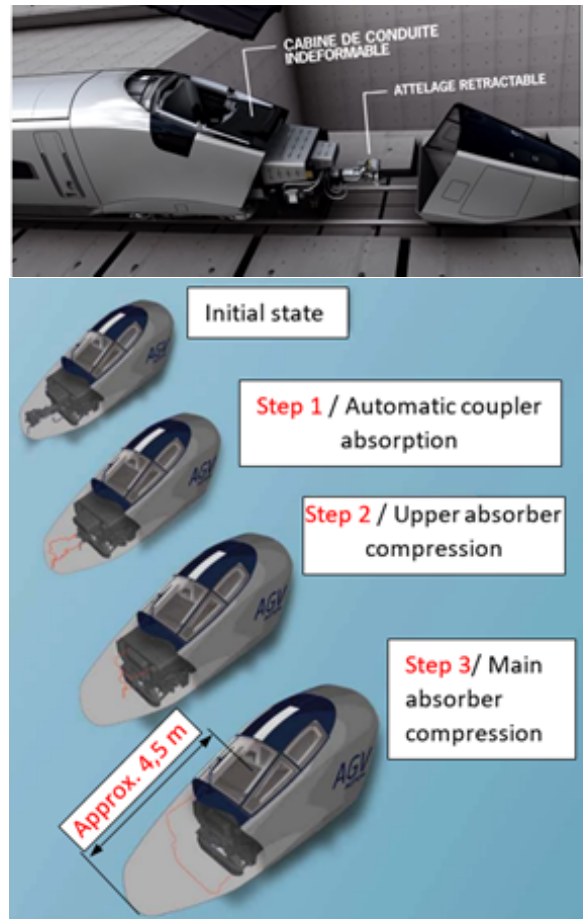
Figure 4. Visualization of energy absorption device – HSR train unit AGV